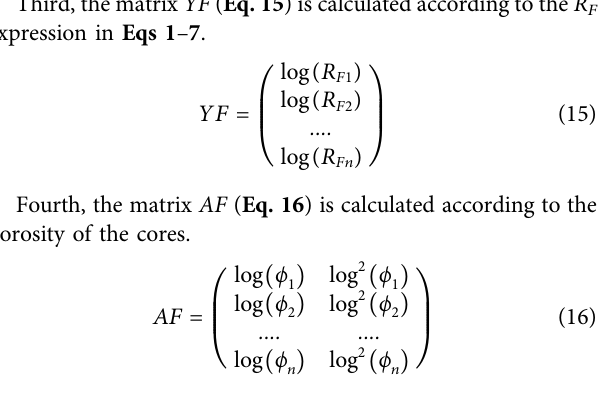
FIGURE 5 | Three groups of all the 19 Cd